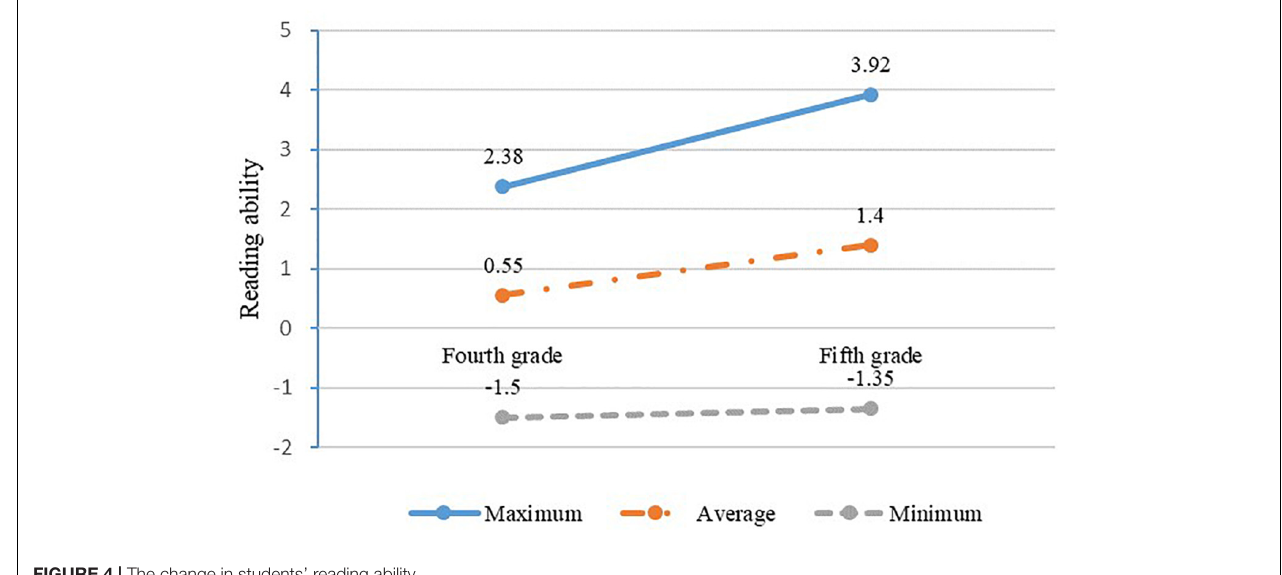
FIGURE 4 | The change in students’ reading ability.